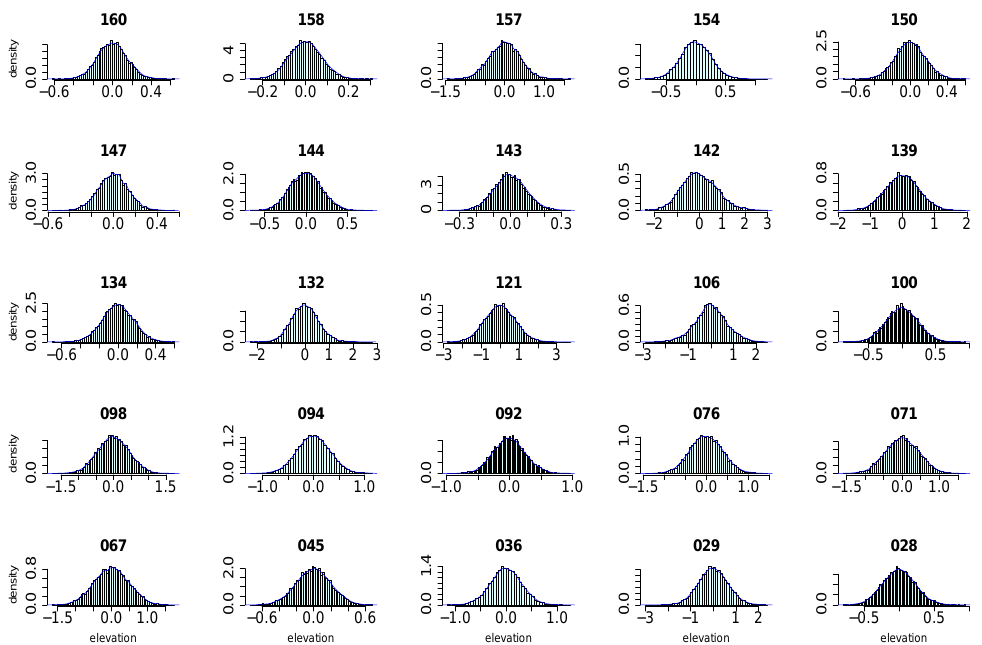
Figure 3. Histogram, based on 70 cells (but for buoy 241 on 40 cells), and kernel density estimated curve associated to each of the 55 buoys (time series) analyzed for a time period of 2.13 h in general and of 1.05 h for the buoys in B